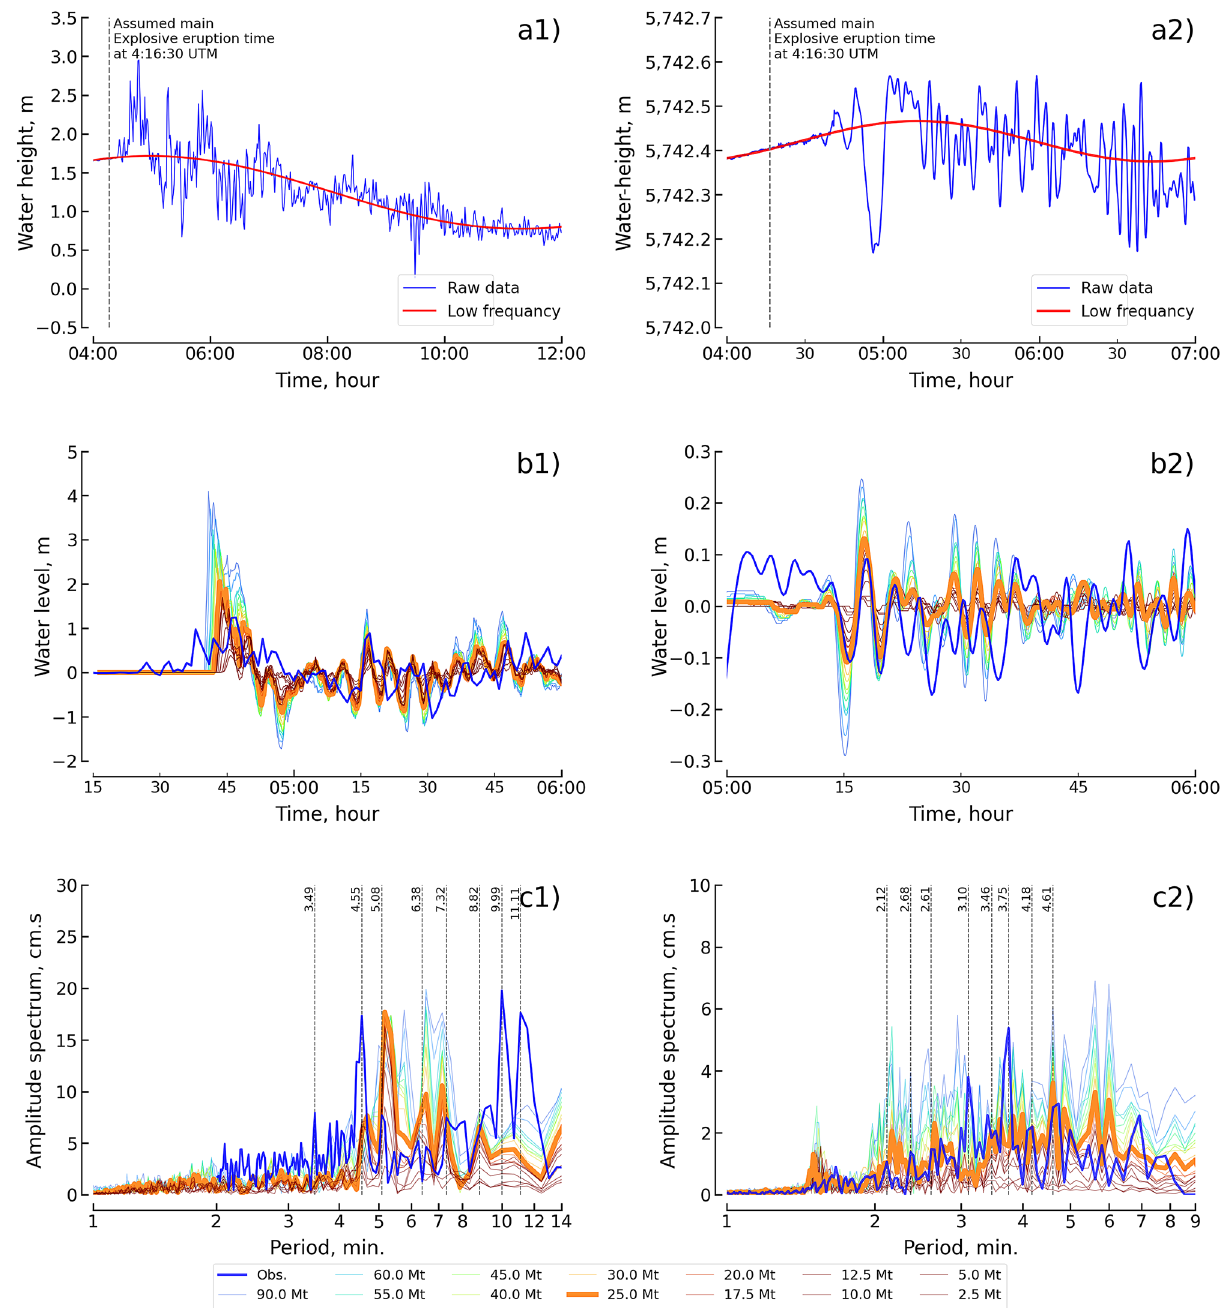
Figure 5. Waveform and wave characteristics of observation and simulation results, showing the Nuku’alofa station in the 1st column and the NZG station in the 2nd column. ( a ) Waveform beginning at 4:00 UTC on 15 January 2022. ( b ) Filtered time series data from the high-pass filter compared to the simulated waveforms of the 20 explosion scenarios with the deep sea depth condition. ( c ) Comparison of wave characteristics in the amplitude